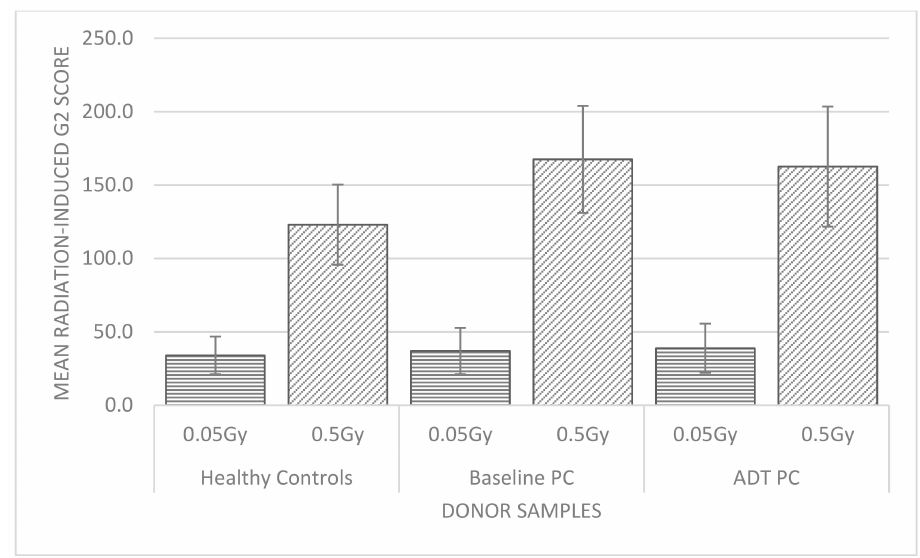
Figure 1. Mean radiation-induced G2 chromosomal radiosensitivity scores for each donor sample group at 0.05 Gy and 0.5 Gy IR. G2 chromosomal radiosensitivity scores were calculated as the number of aberrations per 100 metaphases for all donor samples at 0, 0.05 and 0.5 Gy and adjusted according to the 0 Gy G2 score for radiation-induced G2 scores for both 0.05 Gy and 0.5 Gy doses per donor